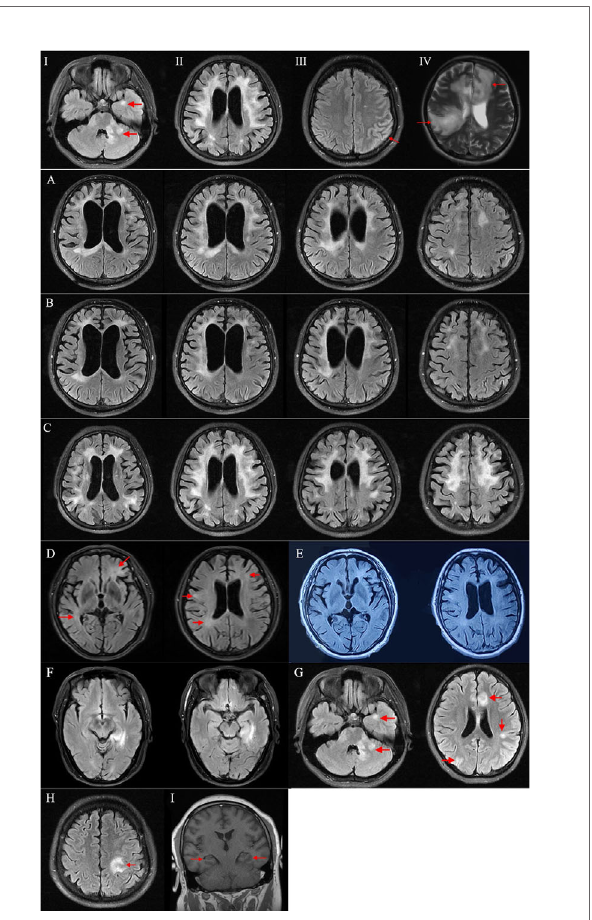
FIGURE 3 | Brain MRI in MOG-E patients. (I – IV) : Representative images of four brain MRI patterns in MOG-E. (I) Multifocal hazy/poorly marginated lesions; (II) leukodystrophy-like pattern; (III) cortical encephalitis with leptomeningeal enhancement/brain atrophy; (IV) tumefactive demyelinating lesion. (A – F) : Brain MRI in chronically progressive MOG-E. (A) Brain MRI of patient 10 in 2018 showed leukodystrophy-like white matter change with whole-brain atrophy. (B) Brain MRI of patient 10 in 2019 showed slight improvement of white matter change on MRI. (C) Brain MRI of patient 11 showed leukodystrophy-like pattern with whole-brain atrophy. (D) Brain MRI of patient 12 in 2020 showed multifocal hazy and poorly marginated lesions. (E) Brain MRI of patient 12 in 2021 showed no prominent improvement of lesions. (F) Brain MRI of patient 13 showed a lesion in the left hippocampus and parahippocampal gyrus. (G – I) : Brain MRI abnormalities in patients with overlapping MOG-ab and NMDAR-ab. (G) Patient 5 showed multifocal poorly marginated lesions in cortical gray matter, subcortical white matter, and midline structures on MRI. (H) Patient 4 showed cortical and subcortical lesions in the left frontal and parietal lobes on MRI. (I) Patient 7 showed mild bilateral hippocampi atrophy without lesion on MRI. ab, antibodies; MOG-E, MOG-antibody-associated